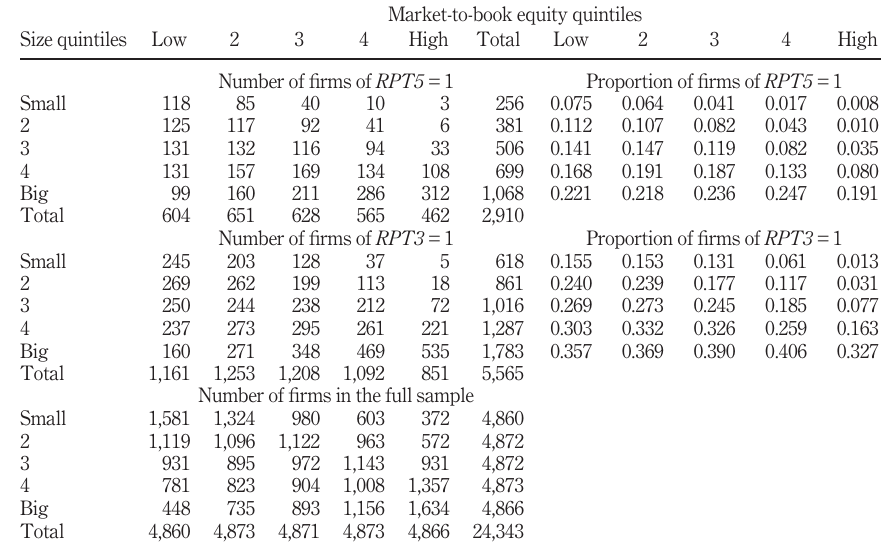
reputation- established fi rms for 25 portfolios formed on size and market- to-book